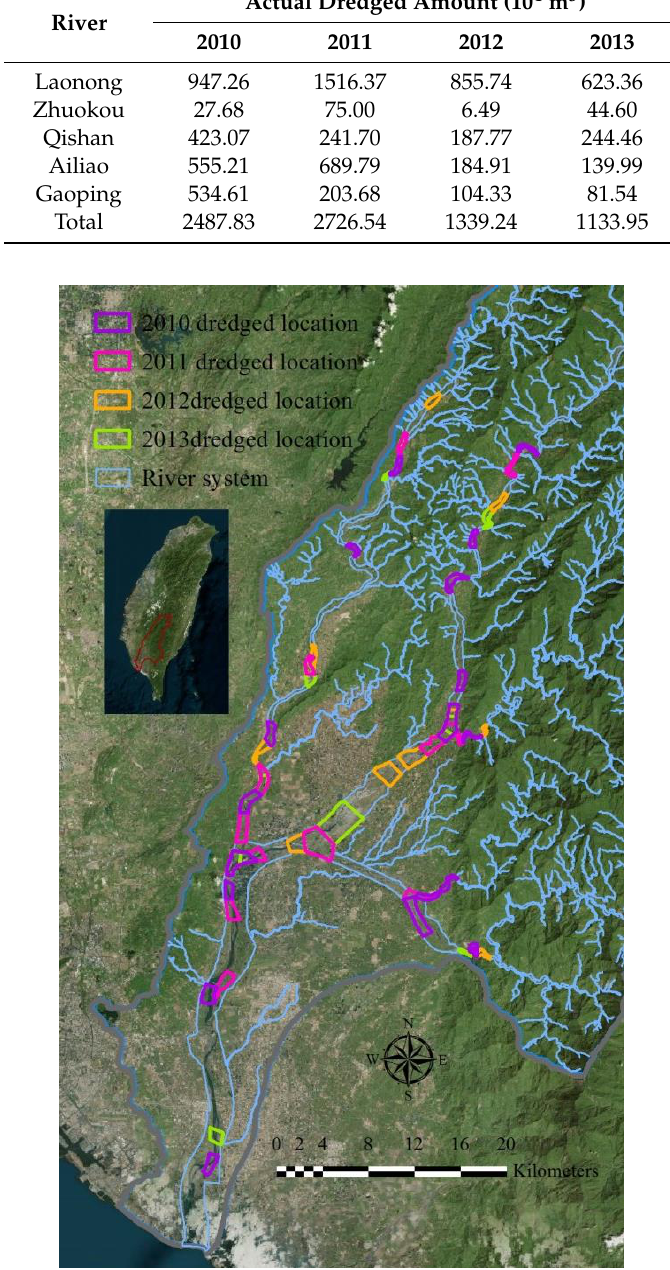
Table 5. The actual dredged sediment deposition amounts from 2010 to 2013 in each river [22].